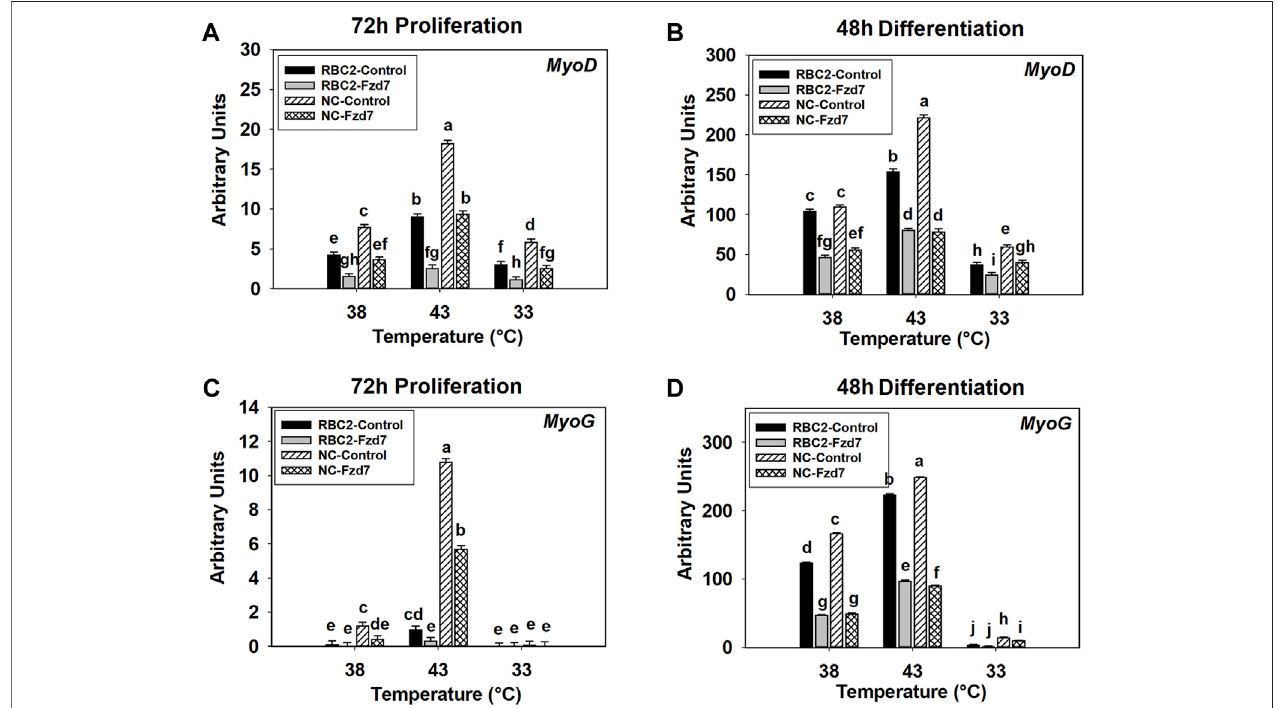
FIGURE 5 | Effect of hot and cold thermal stress and frizzled-7 ( Fzd7 ) knockdown on the expression of myogenic determination factor 1 ( MyoD ) and myogenin ( MyoG ) in satellite cells (SCs). After transfection with either a negative control siRNA or a siRNA targeting Fzd7 , both Randombred Control Line 2 (RBC2) and modern commercial(NC)lineSCsproliferatedat38 ° C,43 ° C,or33 ° C.Expressionof MyoD wasdeterminedat72 hofproliferation (A) and48 hofdifferentiation (B) .Expressionof MyoG was determined at 72 h of proliferation (C) and 48 h of differentiation (D) . Each graph bar represents a mean arbitrary unit, and each error bar represents a standard error of the mean. Mean values with different letters are signi fi cantly different ( p ≤ 0.05).